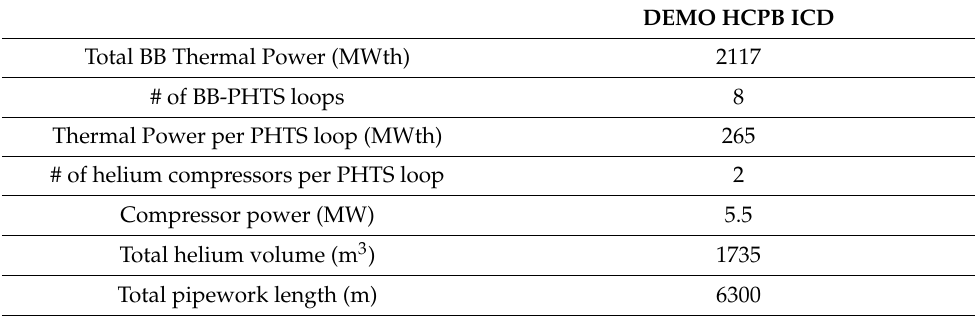
Table 4. Characteristics of the BB PHTS of the DEMO HCPB ICD configuration.